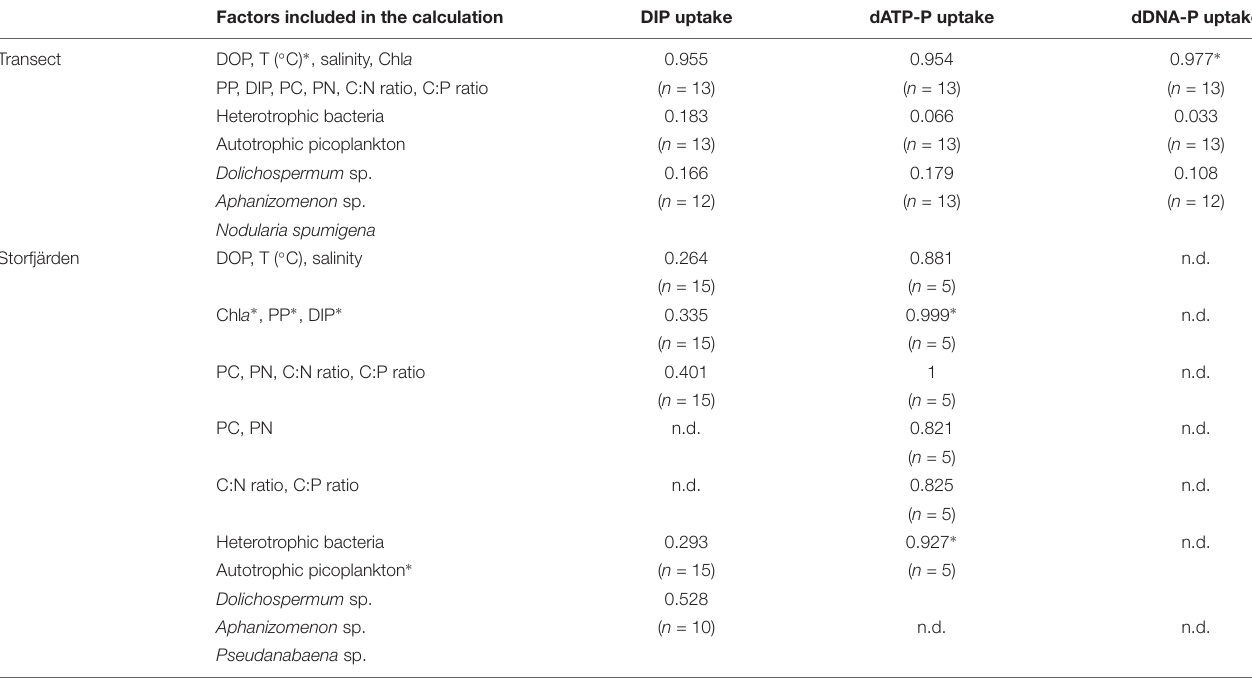
TABLE 7 | Coefficents of determination (CoD) to describe the impact of parameter groups on uptake rates of DIP, dATP-P, and dDNA-P. Factors included in the calculation DIP uptake dATP-P uptake dDNA-P uptake